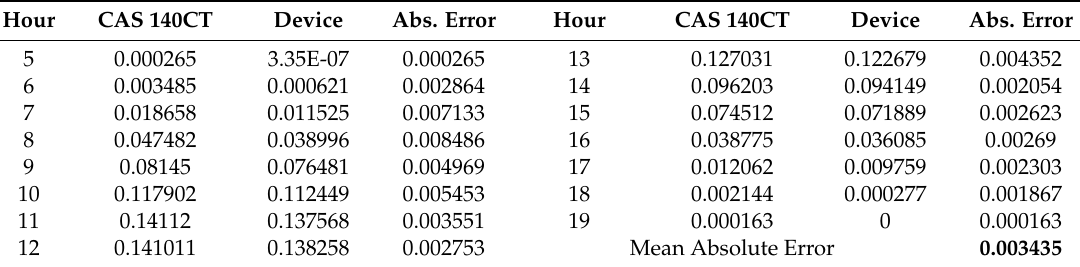
Table 2. Daily EUV measurement data (unit: W/m 2 ).